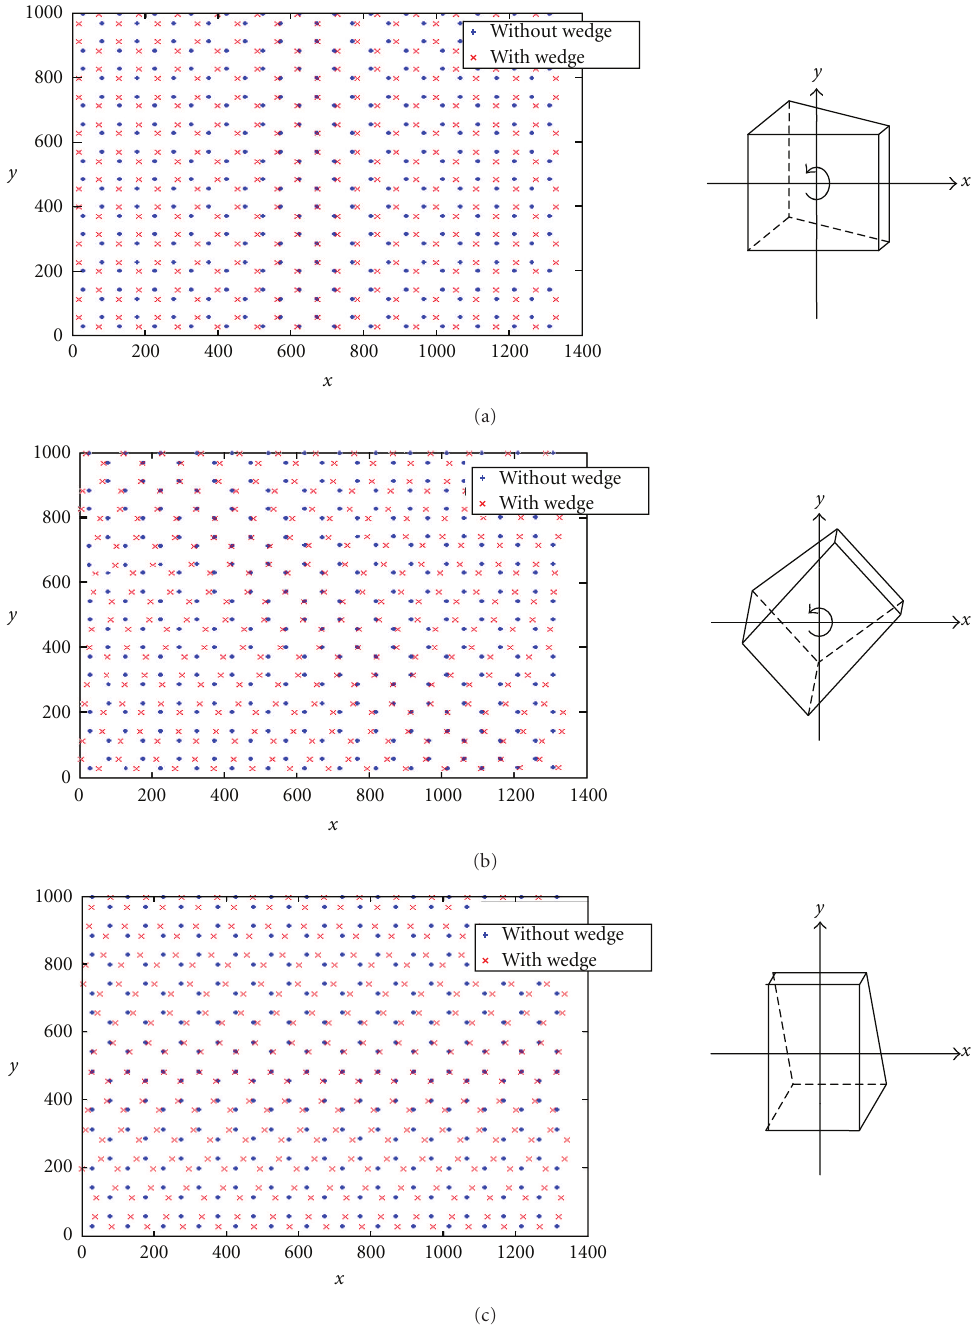
Figure 4: The position of the vortex points (expressed in pixel number) as measured without the wedge (circles) and with the wedge (crosses), (a) wedge inserted horizontally, (b) wedge inserted at β = 45 ◦ , (c) wedge inserted vertically as presented in the right corners. Deflection angle α =